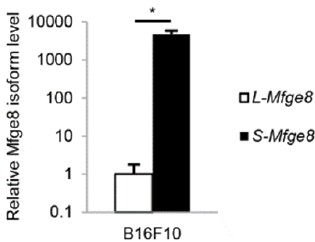
Figure A1. Mfge8 expression is increased in tumor-infiltrated MDSCs. Mfge8 expression in tumor- infiltrated MDSCs in the GEO datasets GSE110772 and GSE21927. Data are expressed as the mean